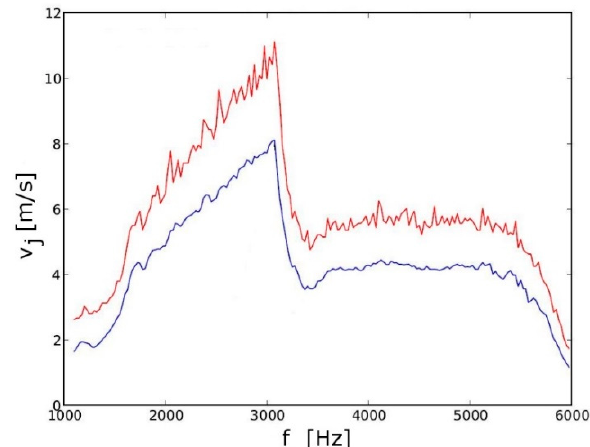
Figure 10. Dependence of jet velocity, v j , on carrier frequency, f . Red is maximum jet velocity; blue is mean jet velocity. (Reprinted by permission of the American Institute of Aeronautics and Astronautics, Inc. (Reston, VA, USA) from [37]).